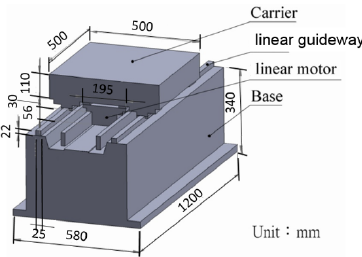
Figure 1. Structural drawing of the moving carrier.